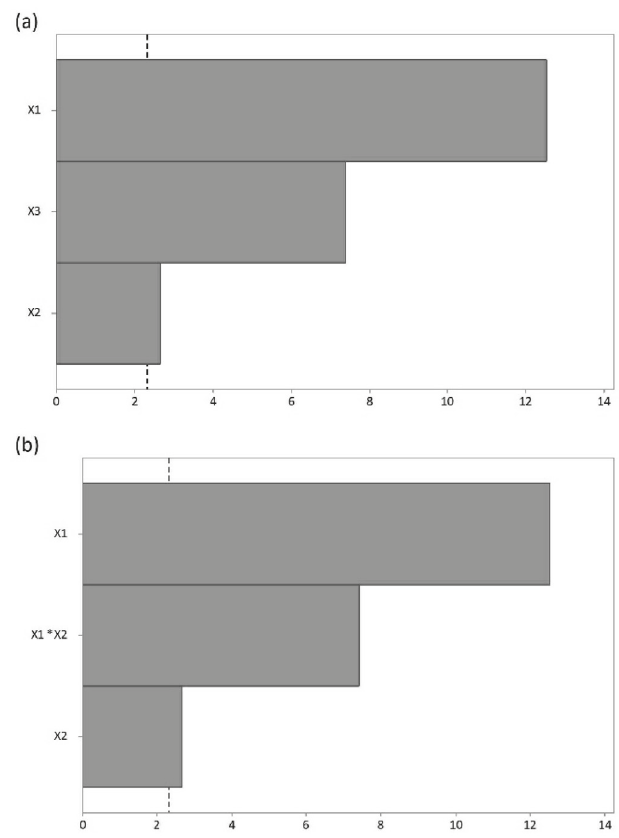
FIGURE 3 – Pareto charts representation for main effects (X1, X2, and X3) of input factors (a), and main effects (X1, and X2) and interaction effects (X1*X2) of input factors (b). Main effect of X3 (a) is aliased with the interaction of X1 and X2